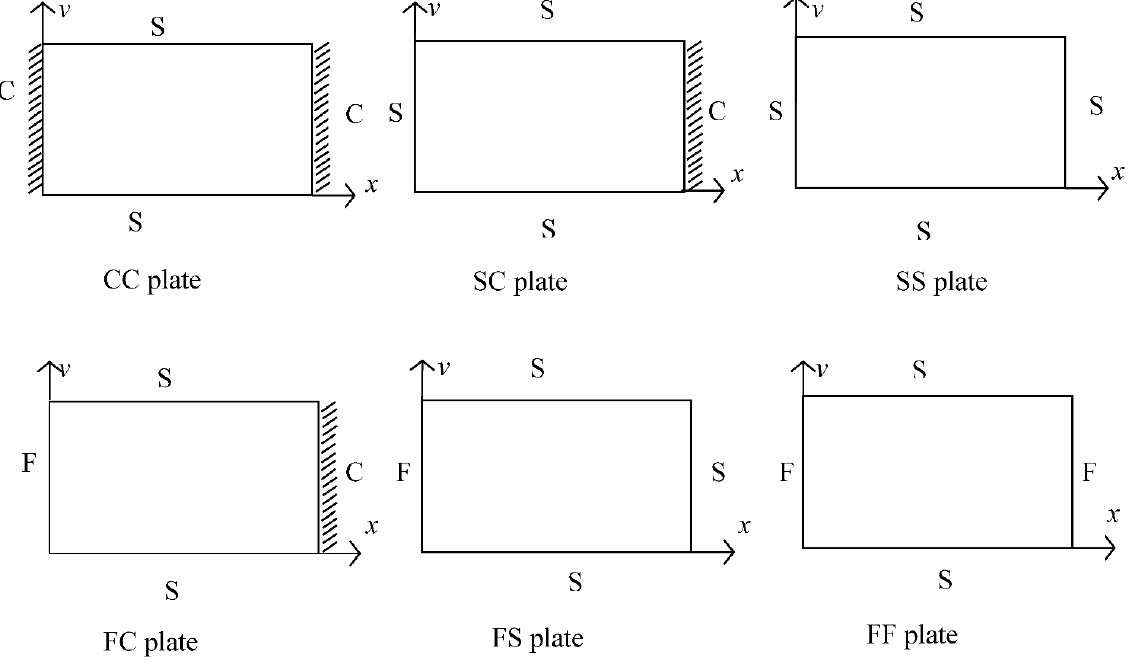
Figure 2. Levy-type solution boundary conditions of the orthotropic plate.